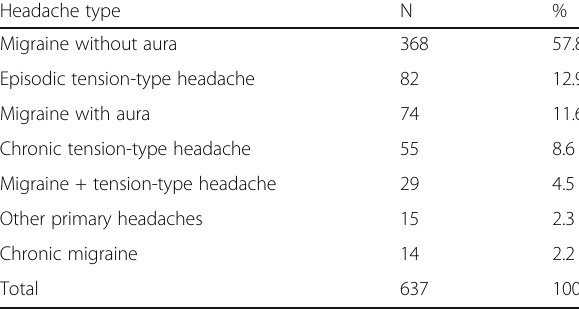
Table 1 Classification of headaches in